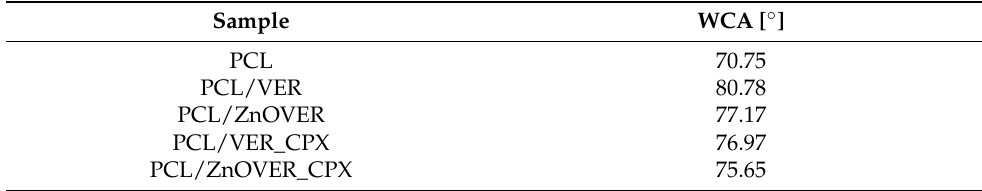
Table 2. Water contact angles (WCA) of the pure PCL thin film and thin PCL/clay nanocomposite films.